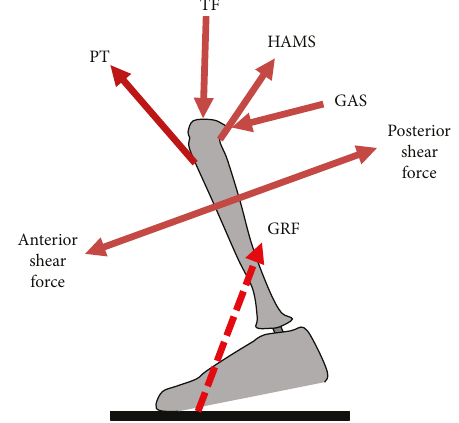
Figure 7: Forces acting at the knee joint [41]. TF: Tibiofemoral joint force; PT: patellar tendon force; HAMS: hamstring muscle force; GAS: gastrocnemius muscle force; GRF: ground reaction stance-heel o ff or contralateral heel strike (CHS), (5) pre- swing or toe o ff , (6) initial swing, (7) midswing, and (8) ter- minal swing. These phases are shown in Figure 9.